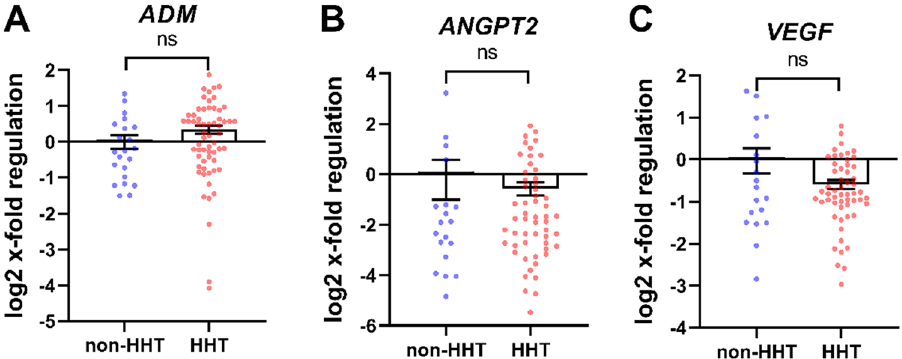
Figure 3. Angiogenesis related gene transcription of whole blood in HHT compared to non-HHT controls. Patients with HHT showed no differences in the regulation of HIF target genes ADM ( A ). ANGPT2 ( B ) and VEGF ( C ). Data are presented as log2 x-fold regulation in mean ± SEM. The Mann–Whitney U test was used to compare the groups, ns = not significant. n (non-HHT) = 26, n (HHT) = 66.